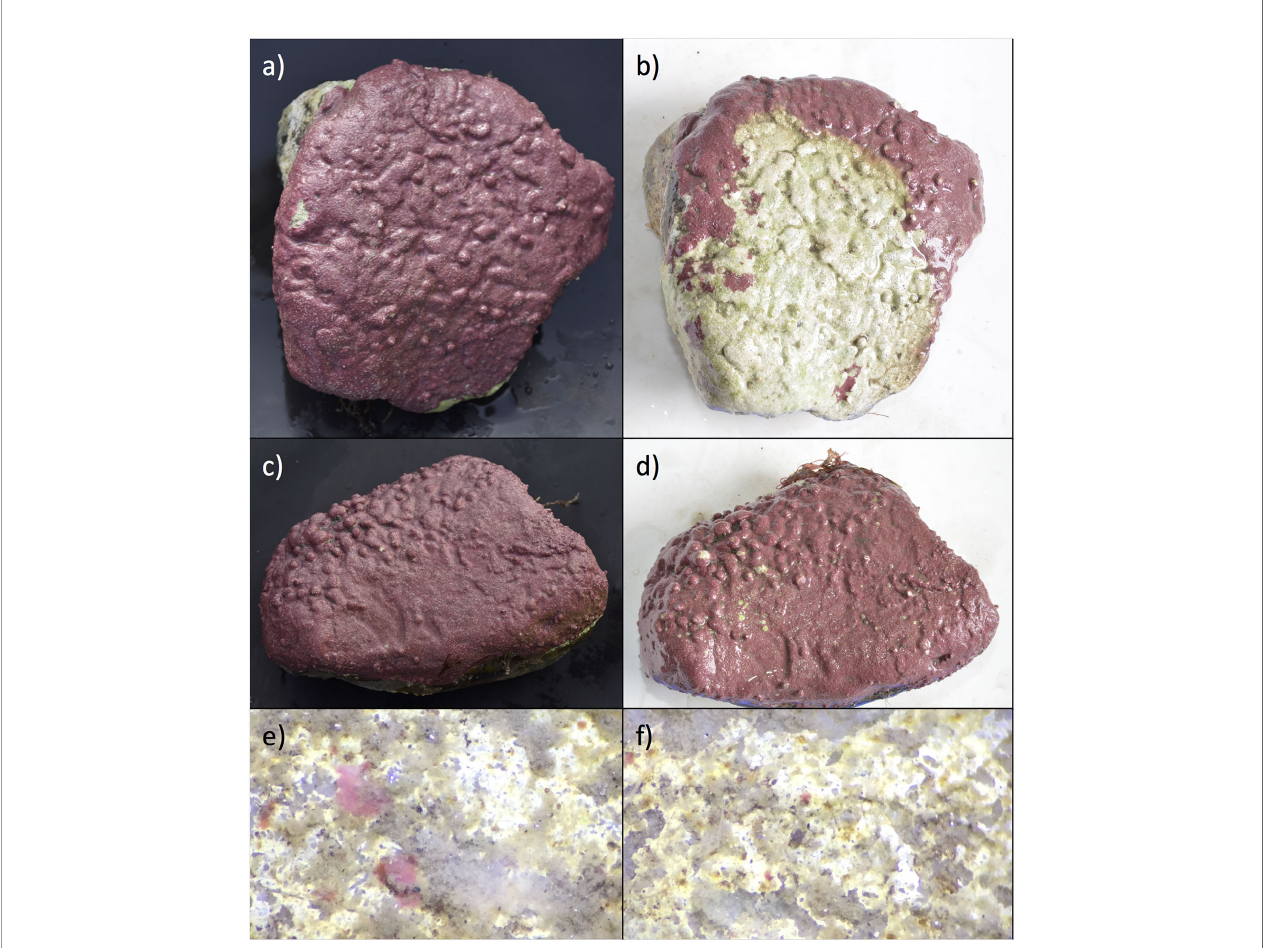
FIGURE 4 | Examples of fi eld experiments, transplanted cobbles and recruits from each site. (A) cobble photographed in 2016 pre-transplant (B) same cobble as (A) , photographed in 2017 following a 12-month transplant to inshore site E-1, showing high pigment loss (C) cobble photographed in 2016 pre-transplant (D) same cobble as (C) , photographed in 2017 following a 12-month transplant to inshore site E-1, showing low pigment loss (E) one year recruits at the offshore site at 400× (F) one year recruits at the inshore site at